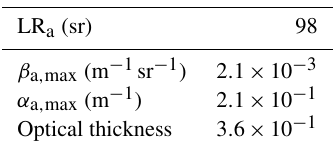
Figure 10. Retrieved β a (r) for real measurements with LR a = 98sr. Table 4. Optical properties of oil-fog plume in experimental setup at